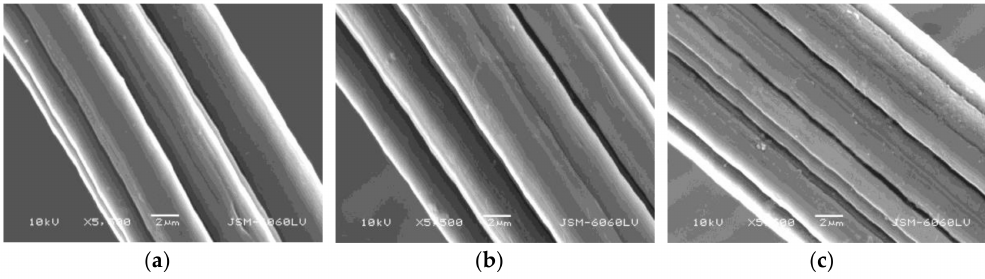
Figure 6. The surface of the biocomposite regenerated cellulose/chitosan fibers ( a ) Untreated; ( b ) ultrasound treated and ( c ) plasma treated; all at a magnification of 5500 × and a voltage of 10